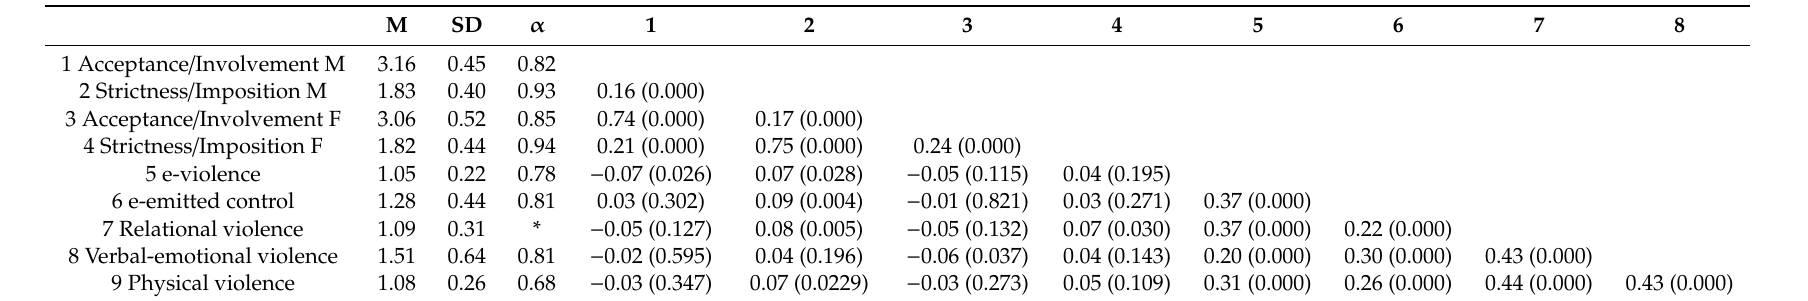
Table 3. Means, Standard Deviations, and Correlations (N =